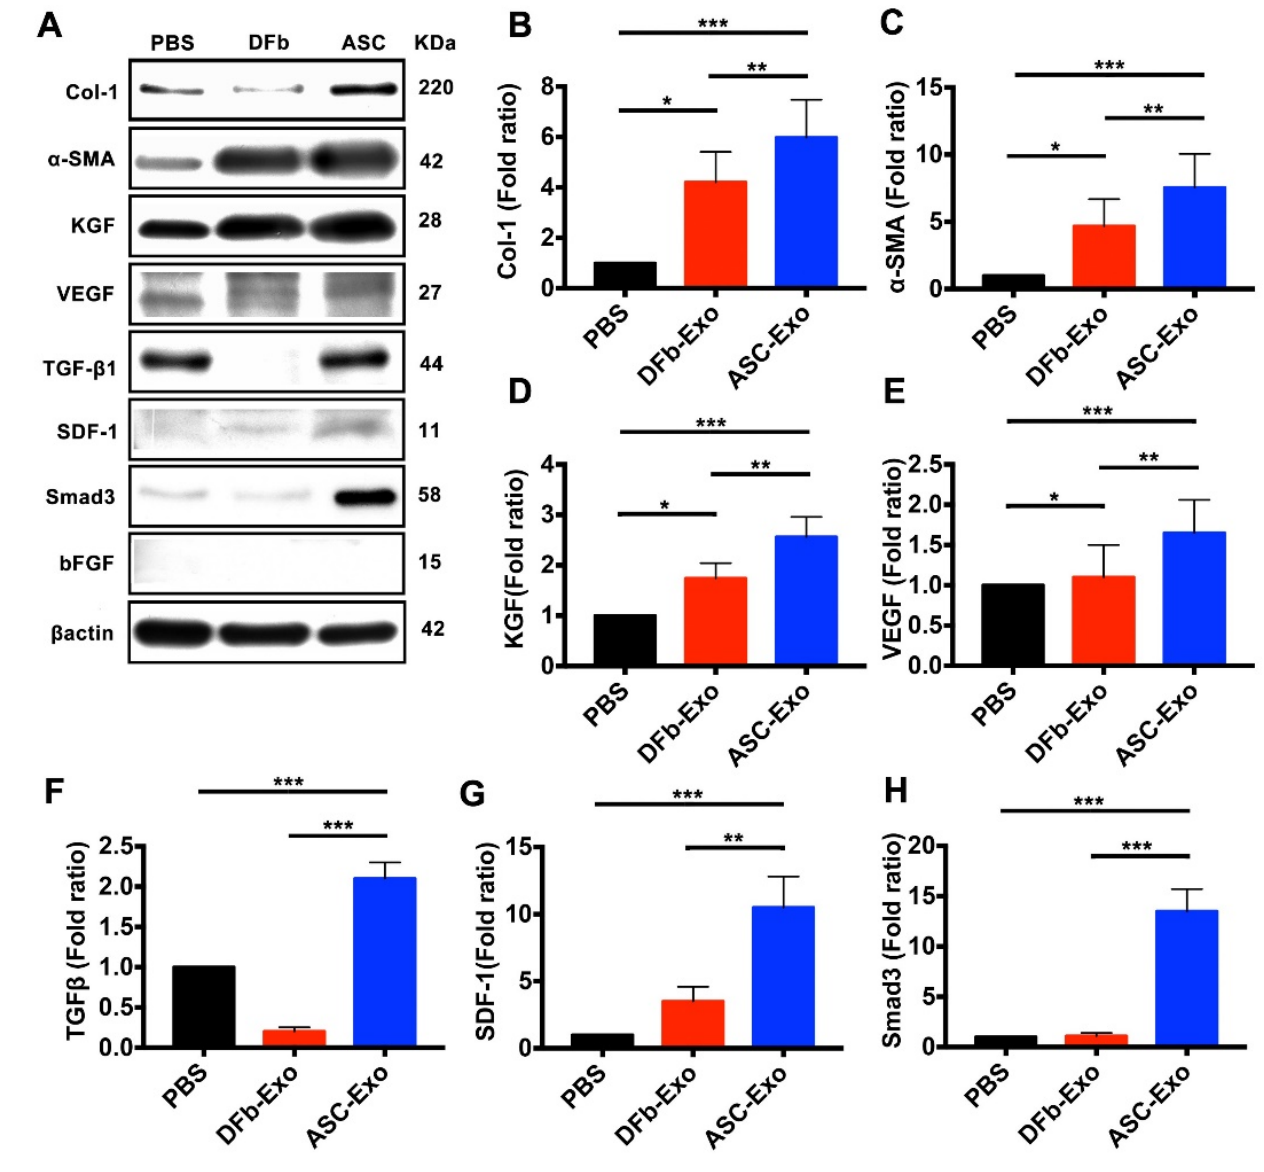
Figure 5. ( A – H ) In vivo Western blot analysis of the protein expression comparing wounds on day 17 from ASC-Exo, DFb-Exo, and PBS-treated mice. Data were standardized by the expression level of β -actin in each sample and presented as the relative expression of those from the PBS group (* p < 0.05; ** p < 0.01; *** p < 0.001). One representative of five independent experiments is shown. Results represent mean ± SE. Data were analyzed using independent unpaired two-tailed Student’s t -tests.